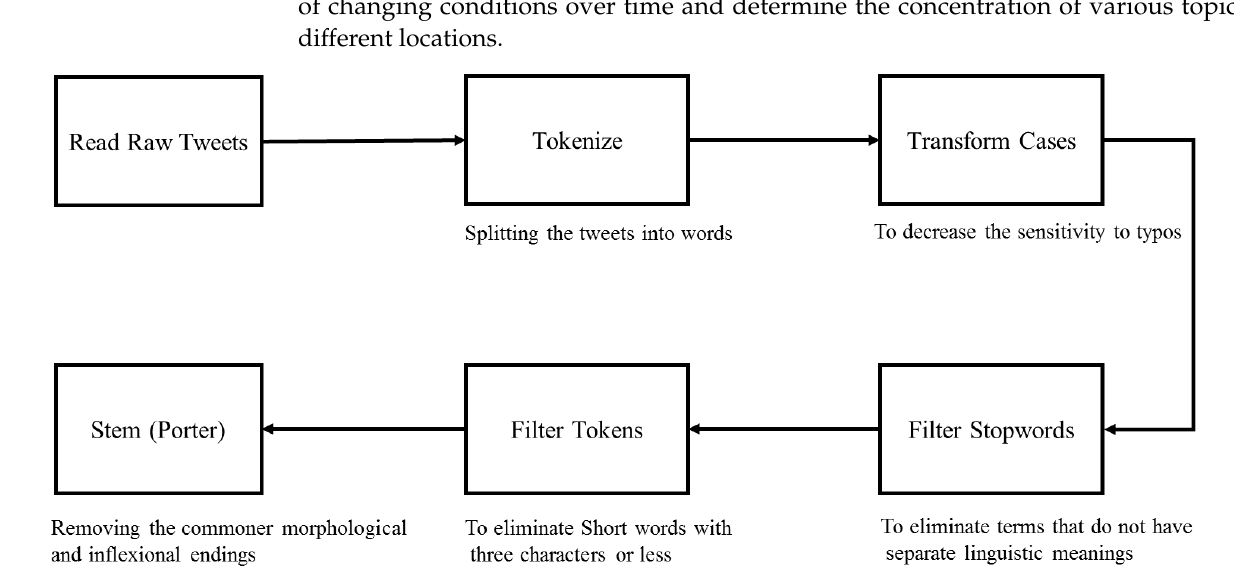
Figure 3. The process of pre-processing textual data [5].